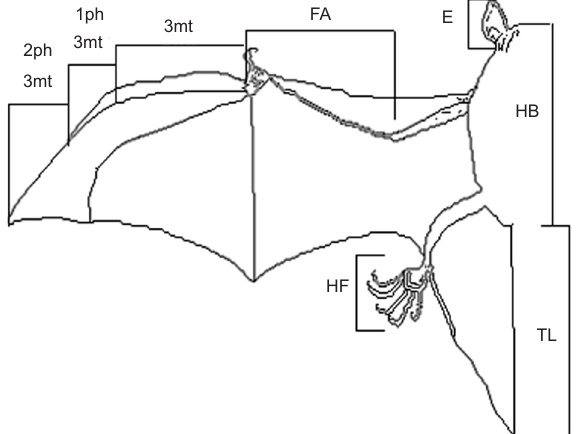
Figure 3a. Schematic diagram of a bat showing important external measurements